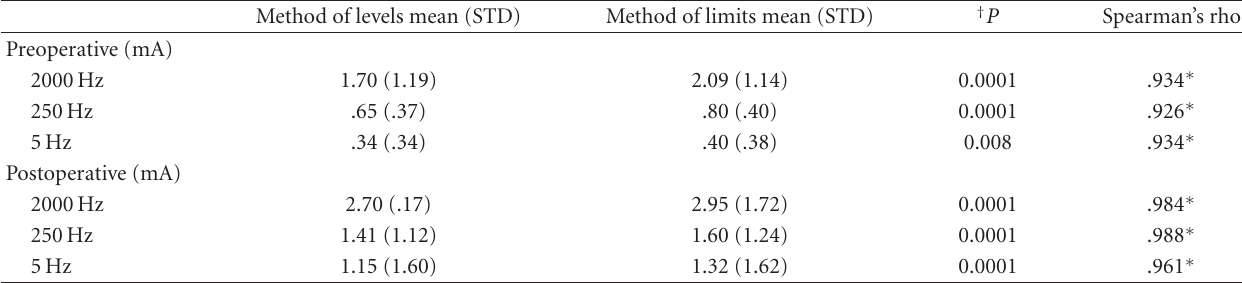
Table 2: Comparison and correlation between threshold levels obtained by methods of levels and methods of